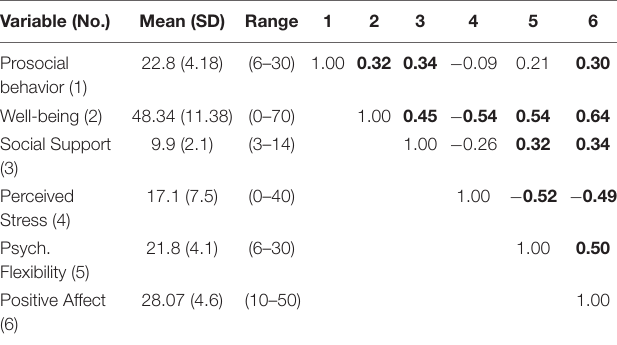
Higher values indicate greater extent of the measured trait; strong correlations are printed in bold; all correlations are statistically significant, p < .001,